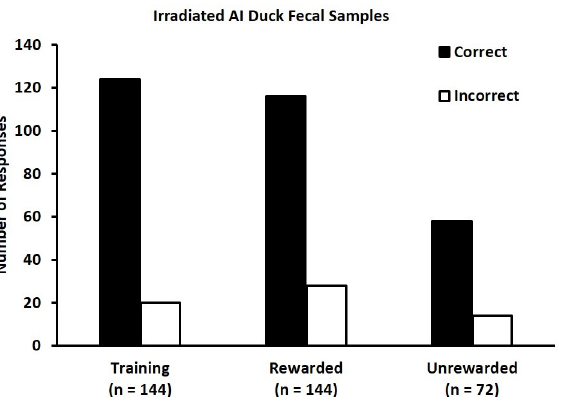
Fig 2. Ferrets can identify irradiated LPAI infected fecal samples in comparison to irradiated pre-infection and non-infected fecal samples. During training, ferrets correctly (black bar; left bars) identified the location of the single fecal sample derived from an LPAI infected donor with 86% accuracy, which was greater than 80% (p = 0.033). During rewarded testing trials, ferrets correctly (black bar; middle bars) identified the location of the CS+ samples with 81% accuracy, which was statistically similar to 75% (p = 0.062). During unrewarded generalization trials, ferrets correctly identified (black bar; right bars) the CS+ samples with 80% accuracy, which was significantly greater than the null hypothesis of 20% (p < 0.0001). White bars represent incorrect